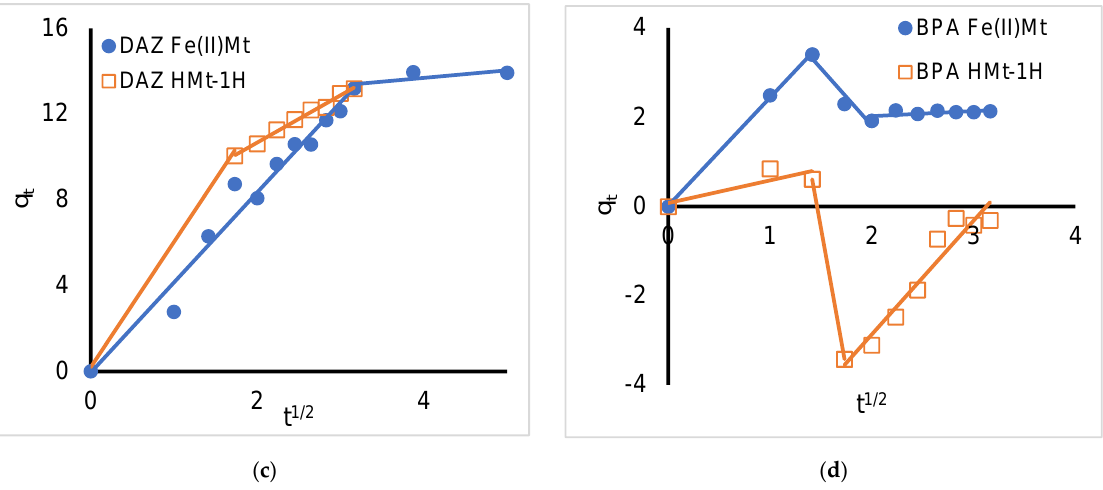
Figure 3. Application of the intra − particle diffusion model to adsorption on Fe(II)Mt and HMt-1 in the aqueous solutions of ATR ( a ), DCF ( b ), DAZ ( c ) and BPA ( d ). Adsorption was achieved in 30 mL of aqueous clay suspension with initial concentration of organic substrate of 30 mg L − 1 at intrinsic